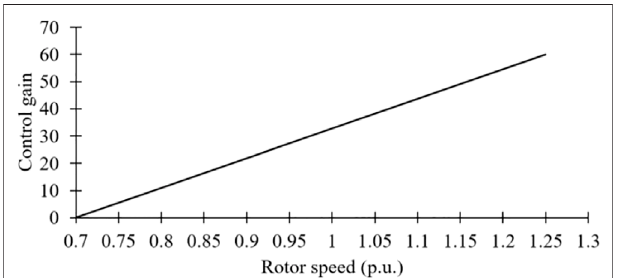
FIGURE 3 | Diagram of conventional control gain when C (cid:1) 60.